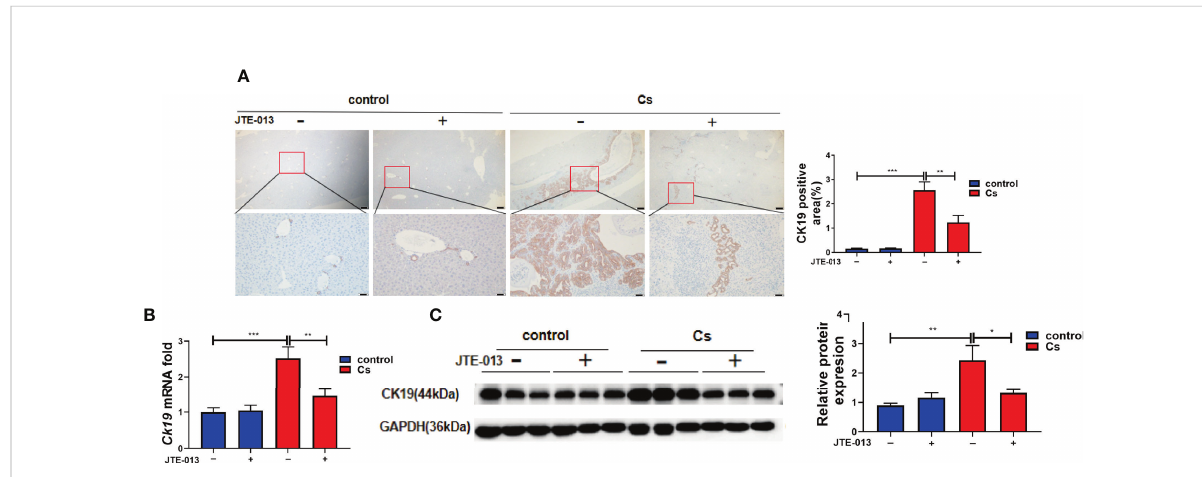
FIGURE 6 The inhibition of S1PR2 alleviated BECs proliferation in mice infected with C. sinensis . (A) The expression of BECs proliferation marker CK19 in infected mice compared to that in control mice. (B) The relative mRNA expression for CK19 in hepatobiliary tissue of control and C. sinensis - infected mice. (C) The protein expression of CK19 in hepatobiliary tissue of control and C. sinensis -infected mice. Compared with indicated groups, * P <0.05, ** P <0.01, *** P <0.001.